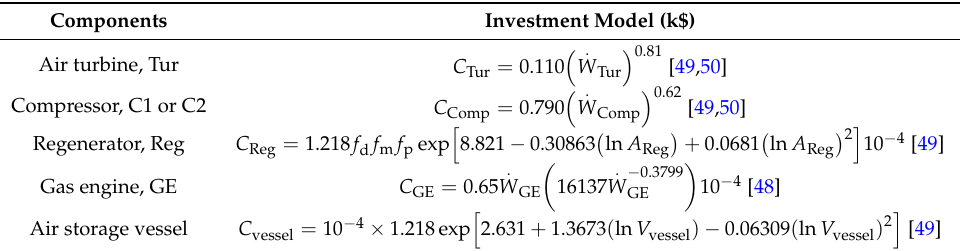
Table A1. Capital cost model of each component of the